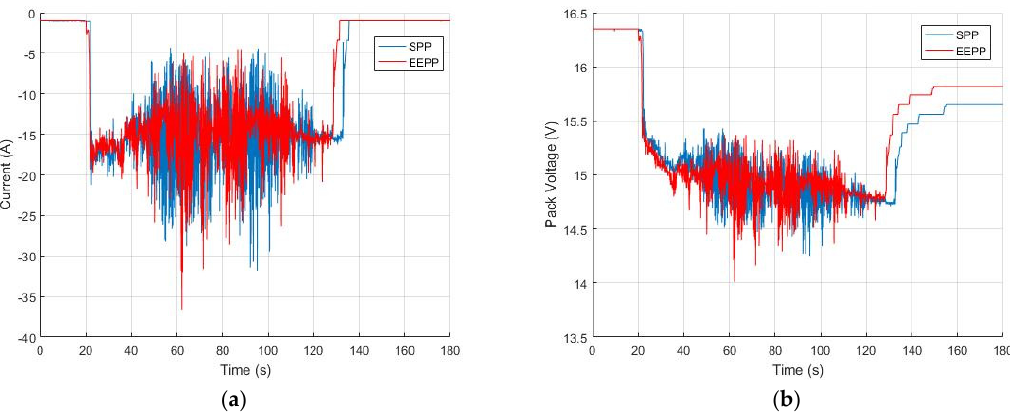
Figure 15. Current and voltage profiles (experiment): ( a ) Current profile and ( b ) voltage profile.